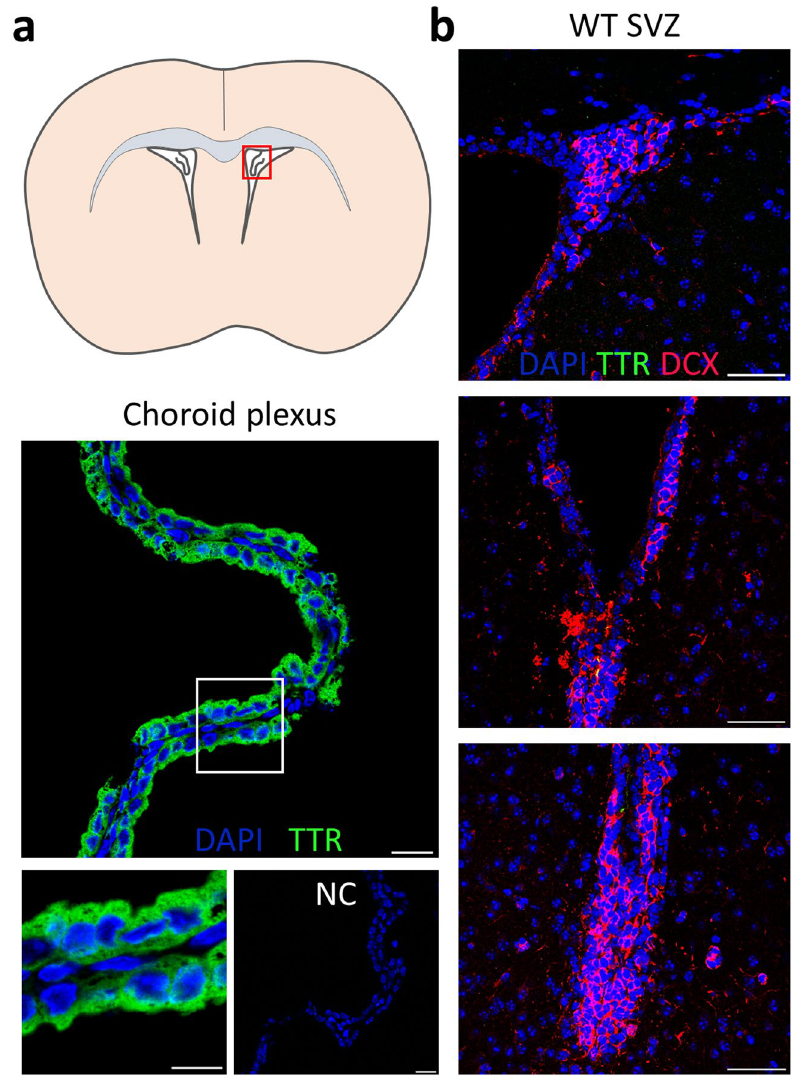
Figure 6. TTR protein is undetectable in the SVZ in vivo . ( a ) TTR staining using the monoclonal Rabbit-anti- mouse TTR antibody on coronal sections from the P4 WT brain shows strong specific signal in the choroid plexus (red box), as expected. Inserts (magnification of white box) show TTR presence in the cellular cytoplasm, while no TTR is detected in the negative control. Scale bars: 50 µ m, insert: 10 µ m. ( b ) No TTR signal was detectable in the dorsal, lateral or ventral SVZ of coronal brain sections of neither male, nor male adult WT mice (n ≥ 3 per group). Scale bars: 50 µ m. NC: negative